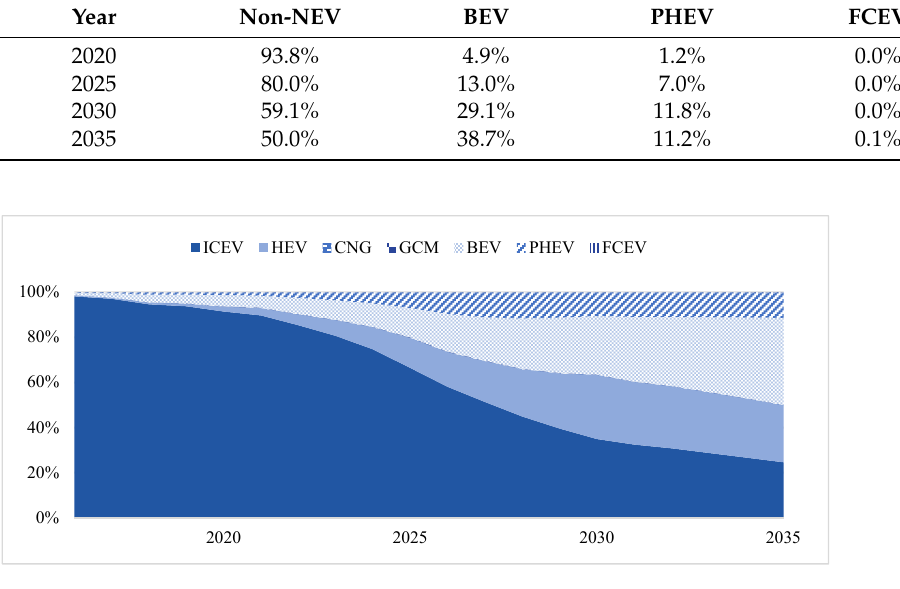
Figure 5. Forecast of the proportion of sales of passenger vehicles by fuel type .